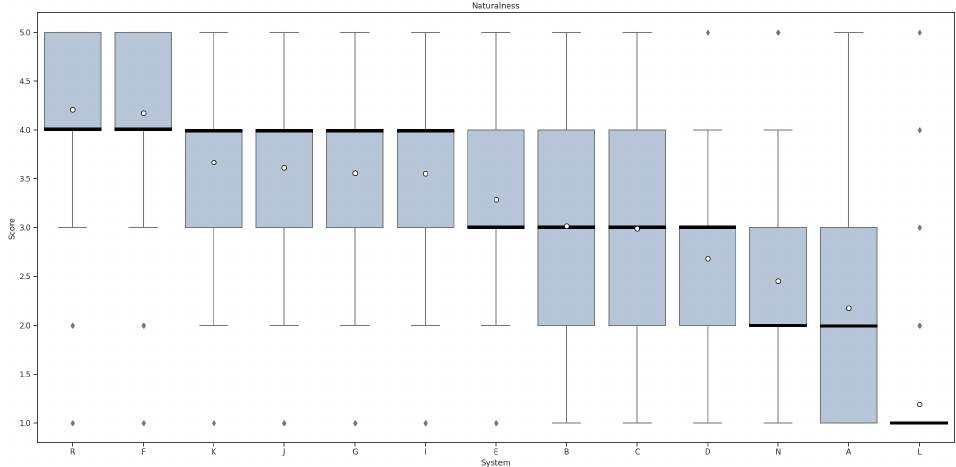
Figure 6. MOS evaluation of the naturalness performed by the Blizzard Challenge Organisation. White dots represent the